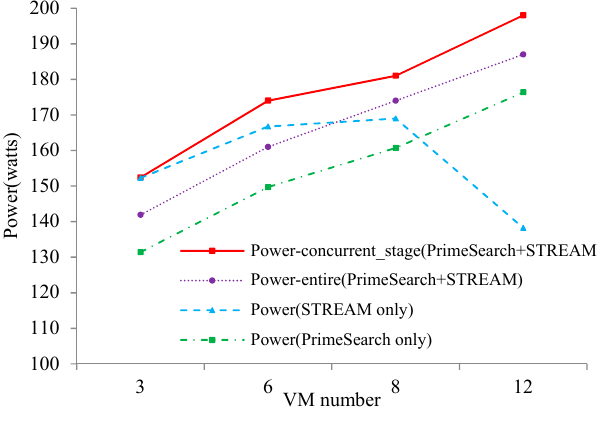
Figure 12. Power consumption of server #3.